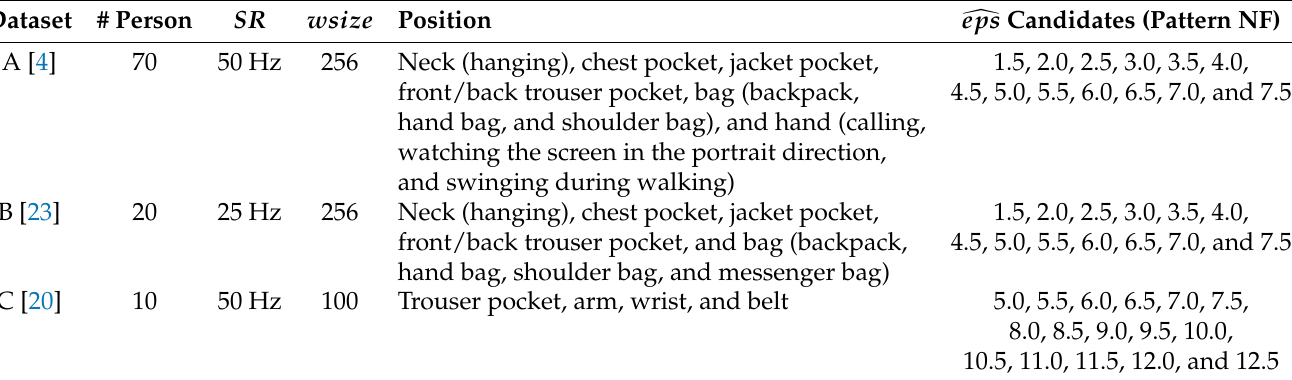
Table 2. The datasets used in the